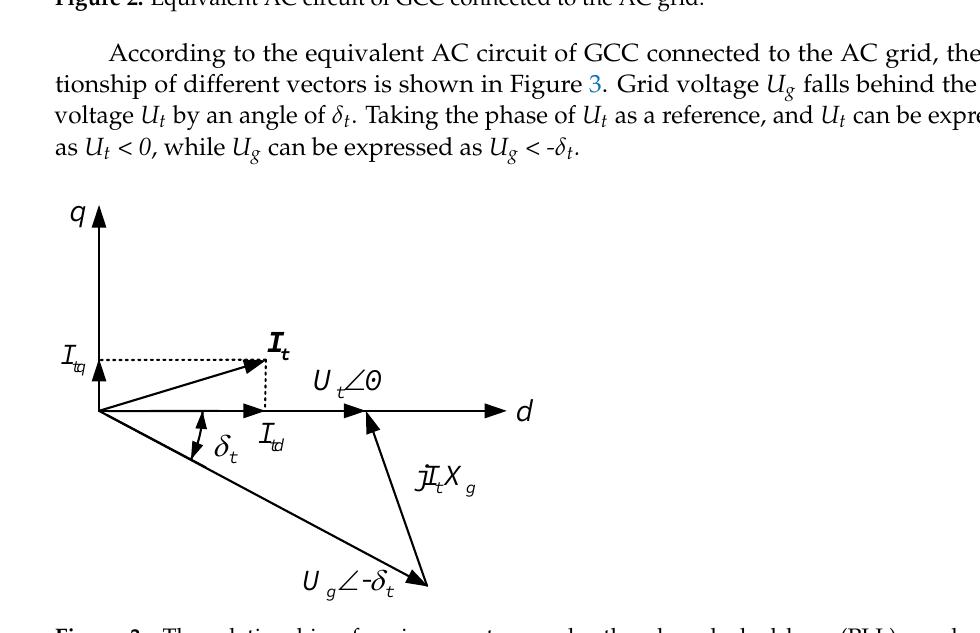
Figure 3. The relationship of various vectors under the phase-locked loop (PLL) synchronous reference frame.